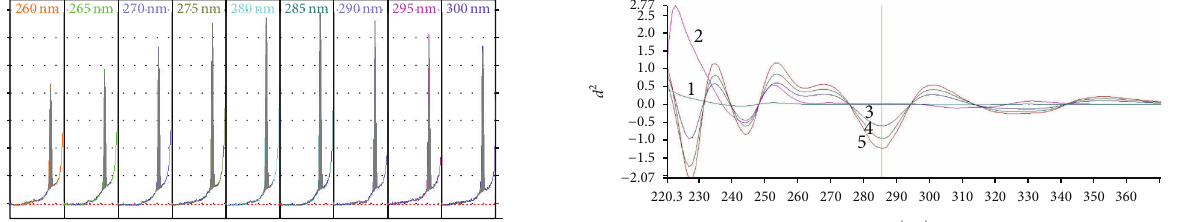
Figure 4: Selected 2nd derivative UV spectra of shampoo solutions and BZ4 standards in pH 6 phosphate buffer-water 1: 20 (v/v).